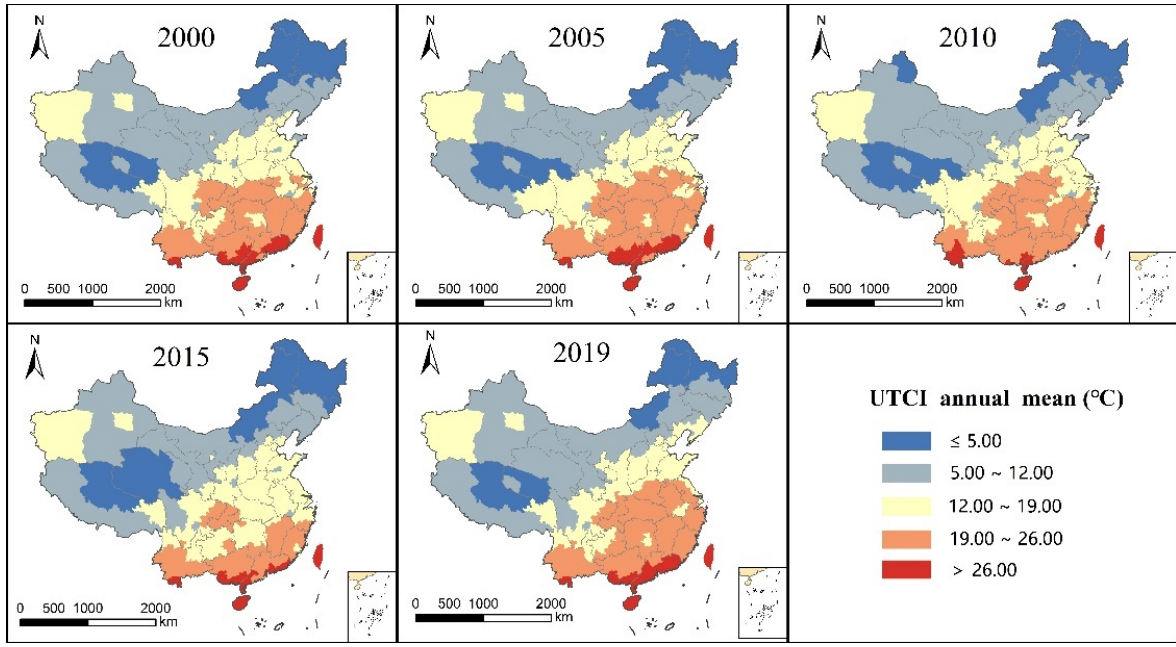
Figure 3. Annual mean distribution of UTCI in China from 2000 to 2020.